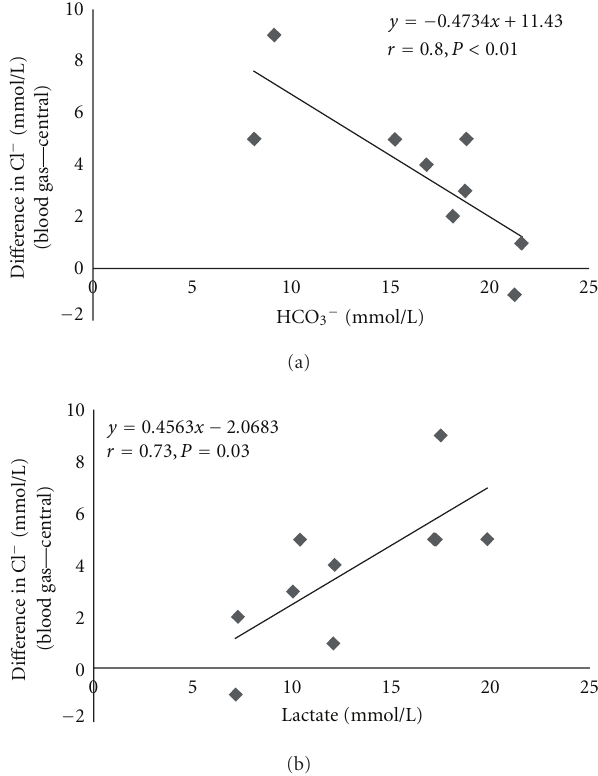
Figure 2: Correlations between the di ff erence in chloride (Cl − ) concentrations determined by two analyzers with bicarbonate (HCO 3 − ) concentrations (a) and lactate concentrations (b) in patients with lactic acidosis.